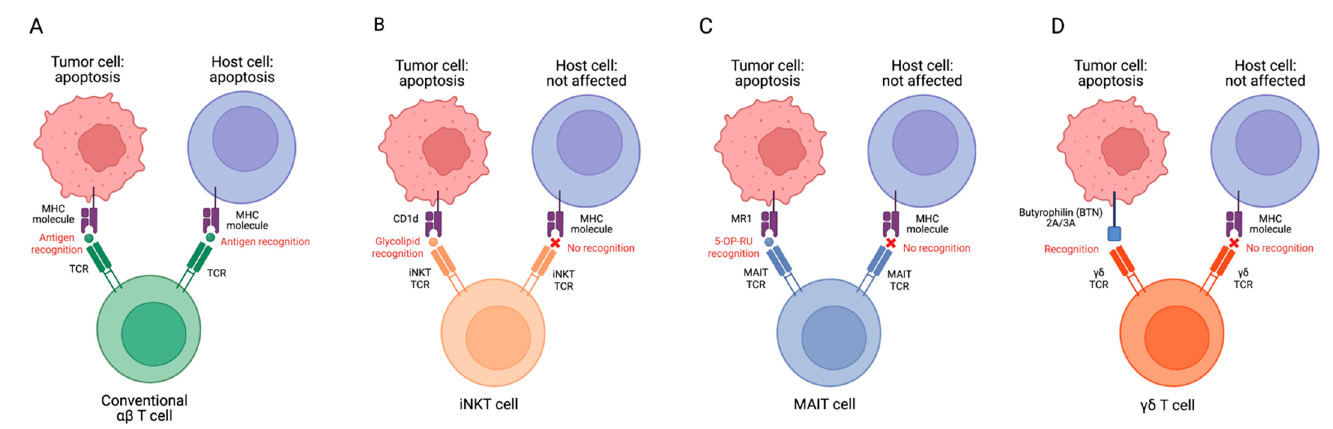
Figure 1. Targeting tumor and host cells by conventional αβ T ( A ), iNKT ( B ), MAIT ( C ), and γδ